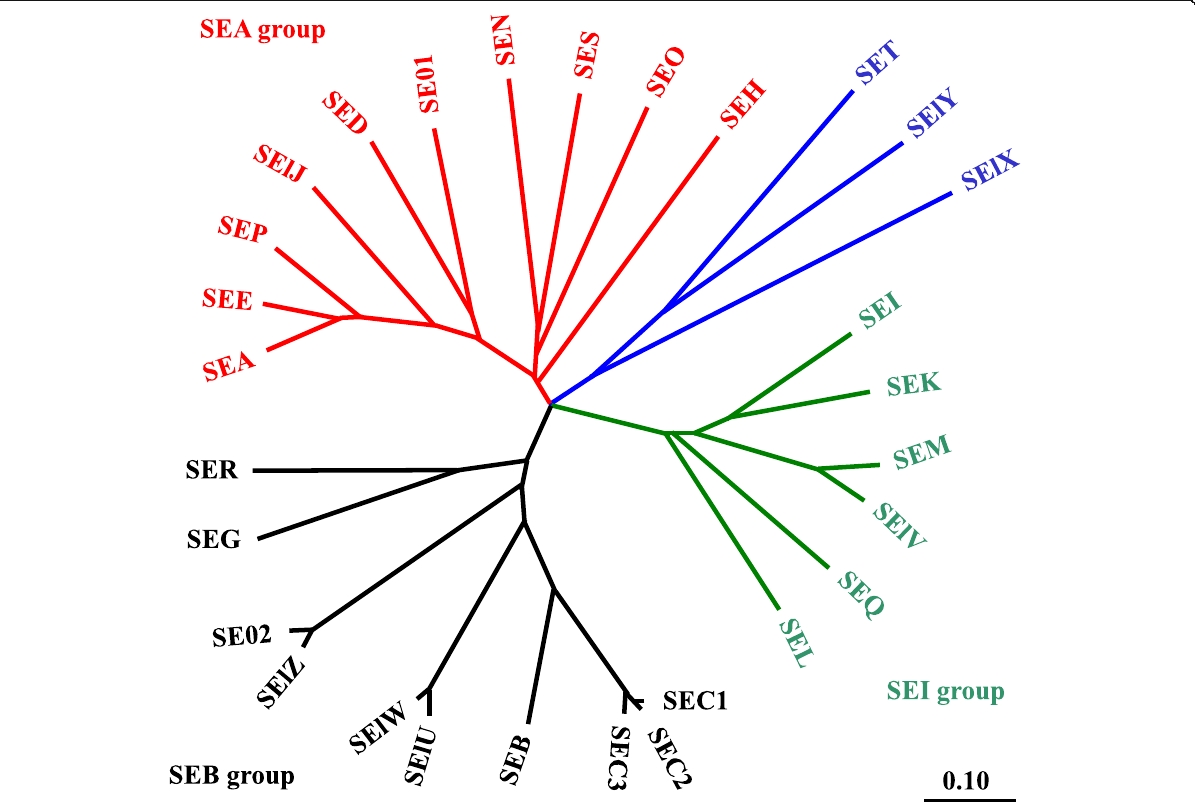
Fig. 1 Superfamily members of SAg toxins and the grouping based on amino acid sequence comparison. SE, staphylococcal enterotoxins. SEA group are showed in red; SEB Group are showed in black; SEI Group are showed in green and the other toxins are showed in blue. This figure was prepared and modified from Hu et al. (2018) and Suzuki et al.